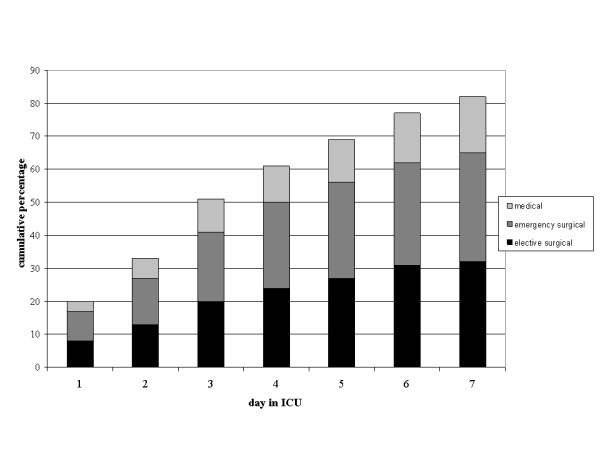
Cumulative incidence of gastrointestinal failure during the first week of stay in intensive care.